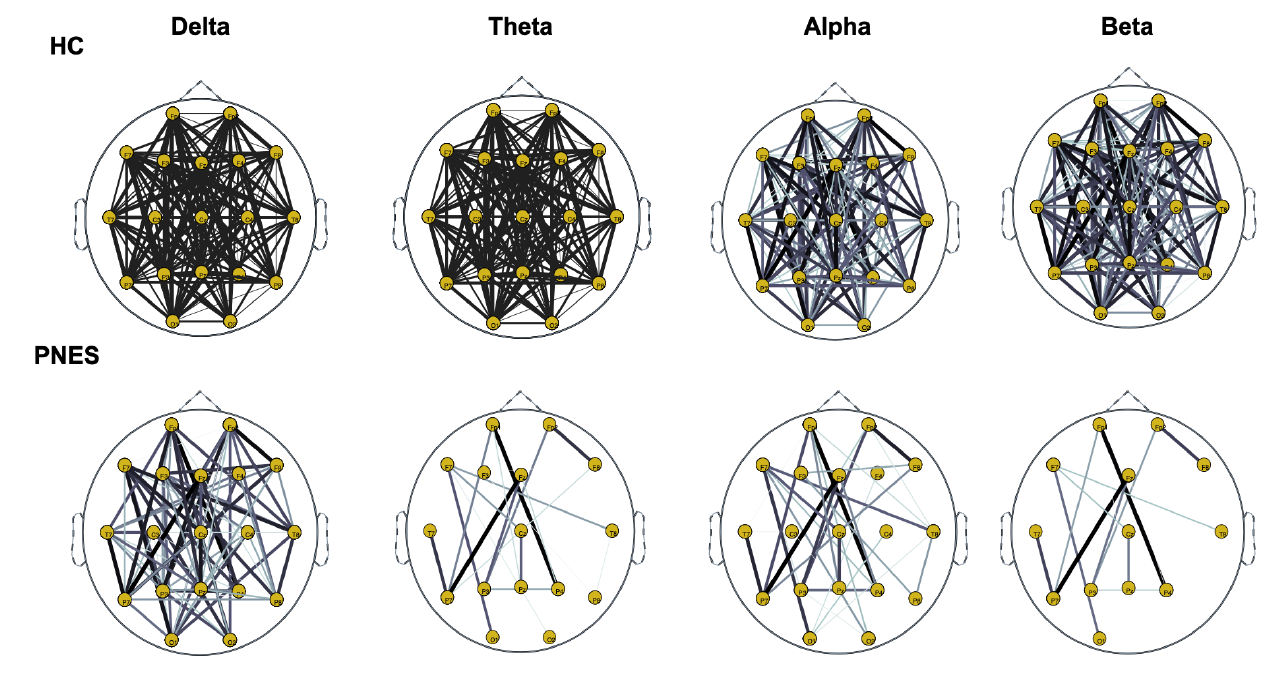
Figure 6. Panel (Distribution of PLI for th = 0.15 level of the connection strength, in healthy subjects and PNES in delta, theta, alpha, and beta frequency